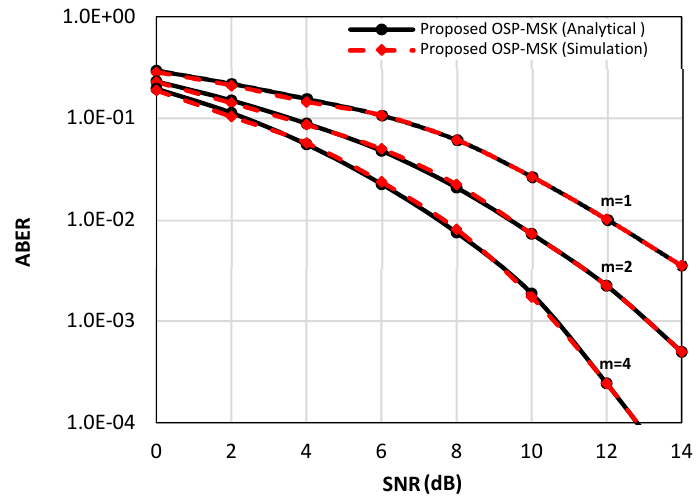
Figure 4. The analytical and the simulated ABER performance of the OSP-MSK modulation over the Raleigh fading channel and Nakagami-m fading channel for the uncoded scenario.